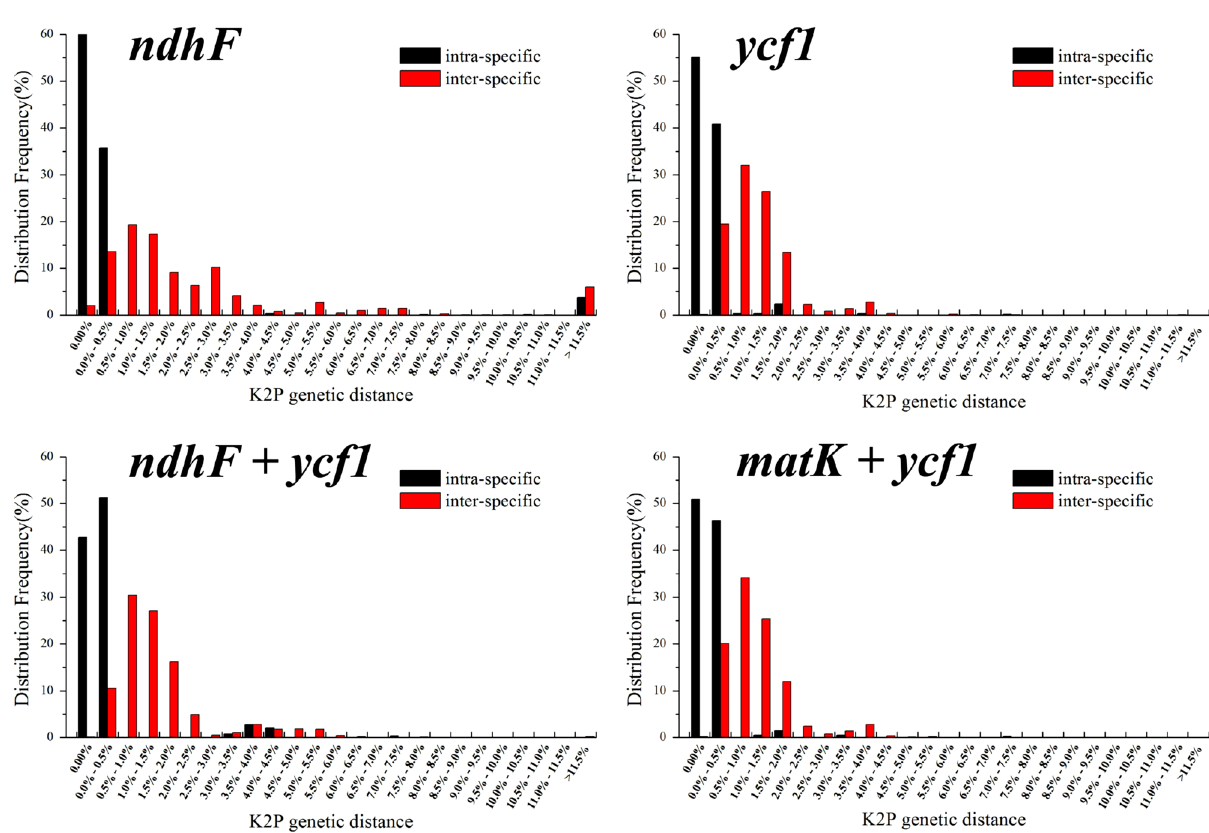
Figure 9. Histogram of frequency of intra-species (black) and inter-species (red) of Orchidaceae based on K2P distance of candidate genes. The X-axis represents the genetic distance, and the Y-axis represents the